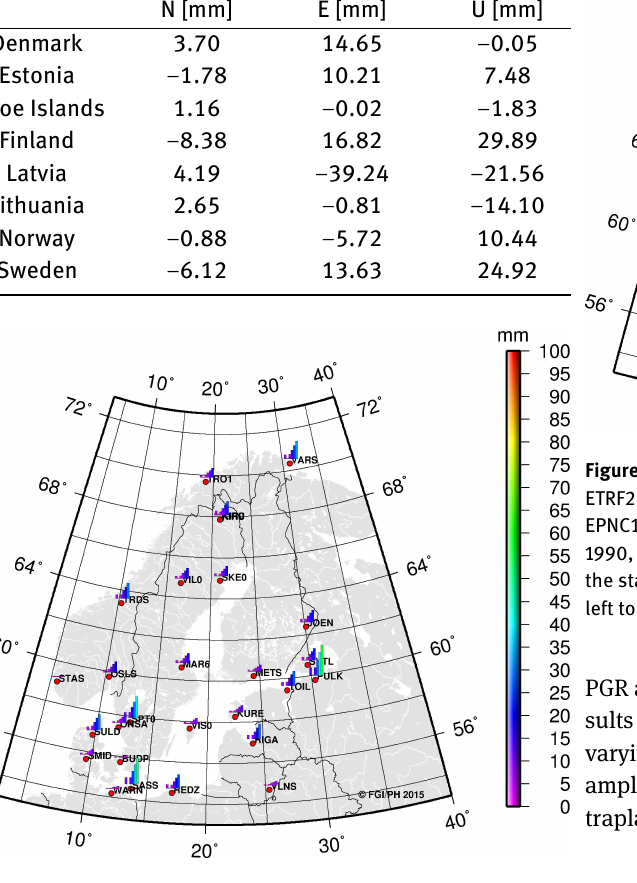
Figure 7: Coordinate difference NKG ETRF 00 minus EPNC1785 in ETRF2000 at the epoch 2000.0 when IGb08 coordinates of the EPNC1785 are first converted with the station velocities to epochs 1990, 2000, 2010, 2020, 2030 and 2040 and then transformed with the NKG2008 transformation to the NKG ETRF 00 . Error bars from left to right show the difference for epochs 1990–2040.